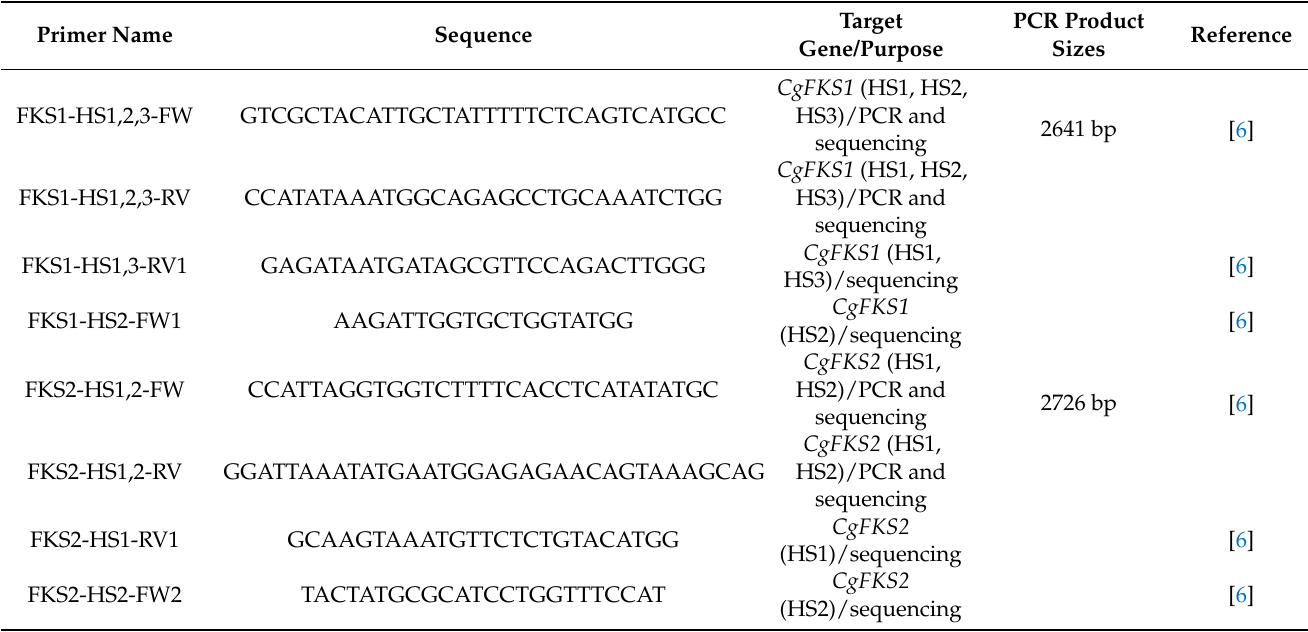
Table 1. Primers used for identification of FKS genes hot spots